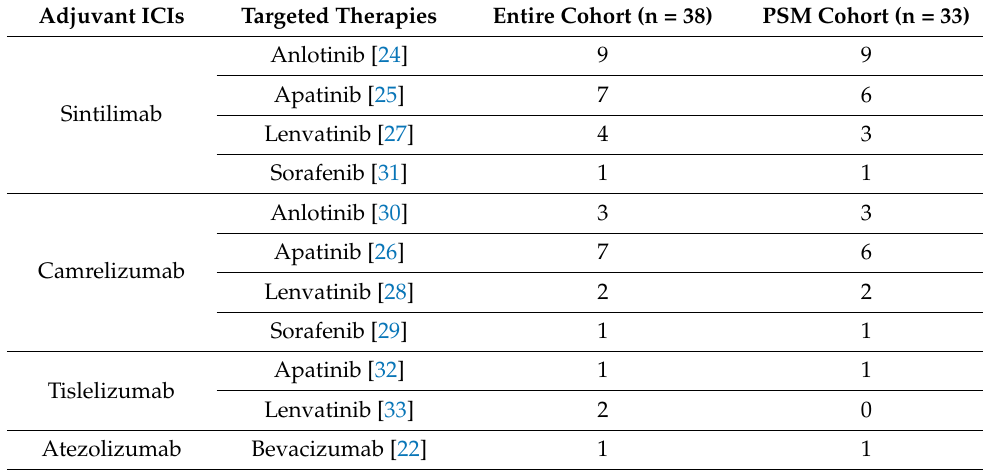
Table 1. Combination regimens of postoperative adjuvant ICIs plus targeted